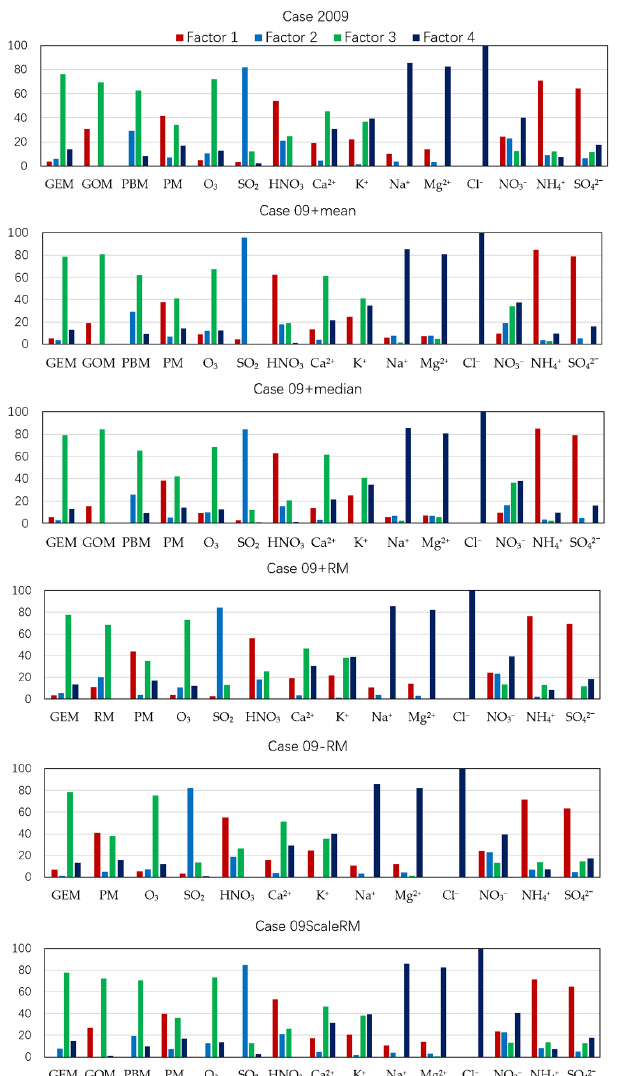
Figure 2. PMF source profiles in percent of concentration, 2009. Figure 3. PMF source profiles in percent of concentration,